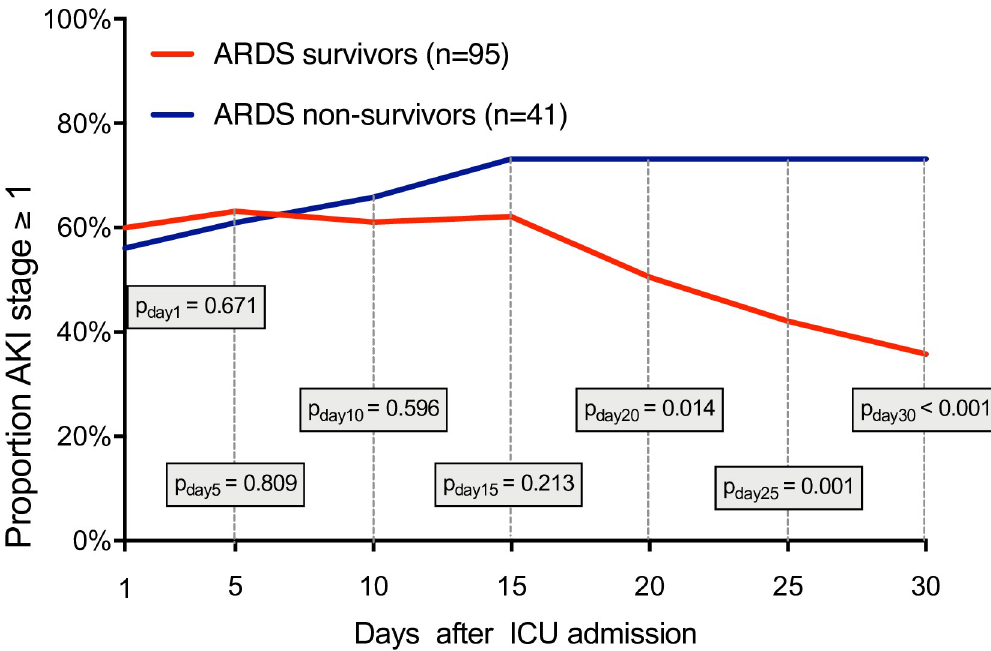
Fig 2. Proportion of all patients (n = 136) with acute kidney injury (AKI stage � 1 according KDIGO criteria) stratified for survivors and non-survivors. Measurements on day 1, 5, 10, 15, 20, 25 and 30.